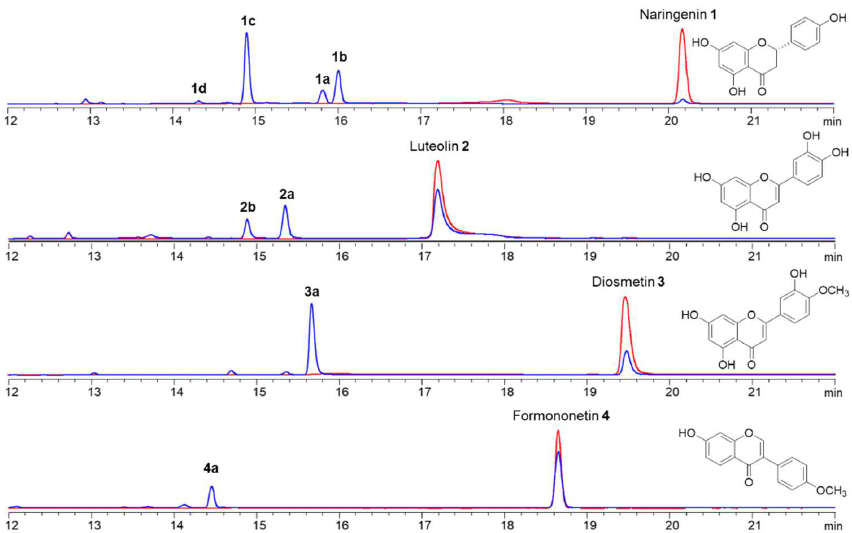
Figure 3. Product profiles of flavonoids 1 – 4 biotransformed in the I. fumosorosea ACCC 37814 cultures (reverse phase High Performance Liquid Chromatography (HPLC) traces recorded at 300 nm). HPLC traces of each standard substrate (colored in red) were used as references.